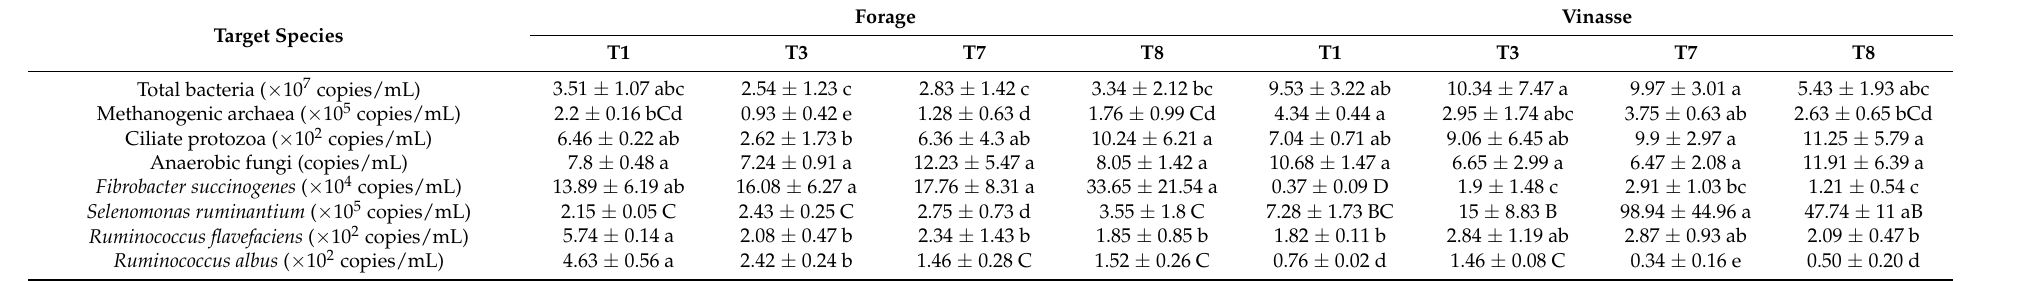
Table 3. Effect of monensin and fumarate supplementation on selected microbial populations under different